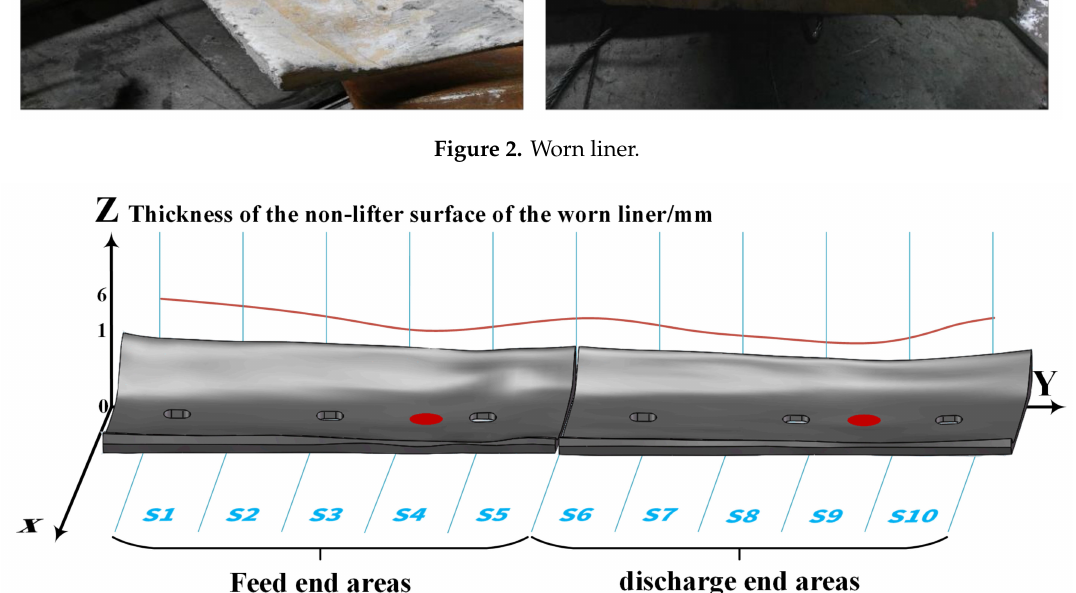
Figure 3. Schematic diagram of the liner area division and thickness of the bottom